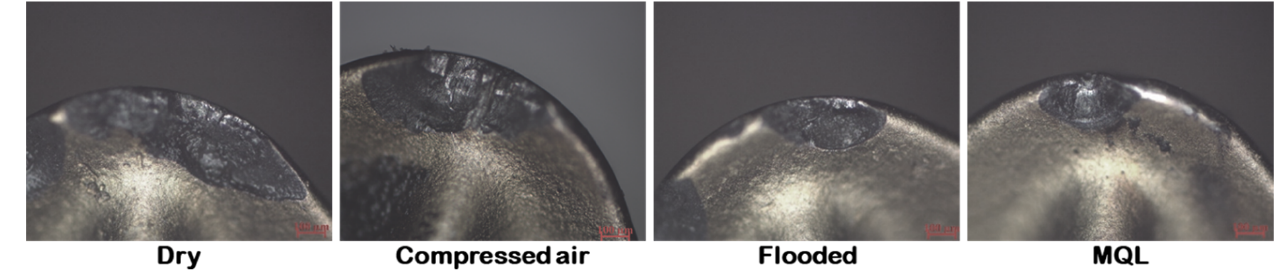
Figure 4. Images of crater wear under several turning environments at v = 67 m/min, f = 0.20 mm/rev.